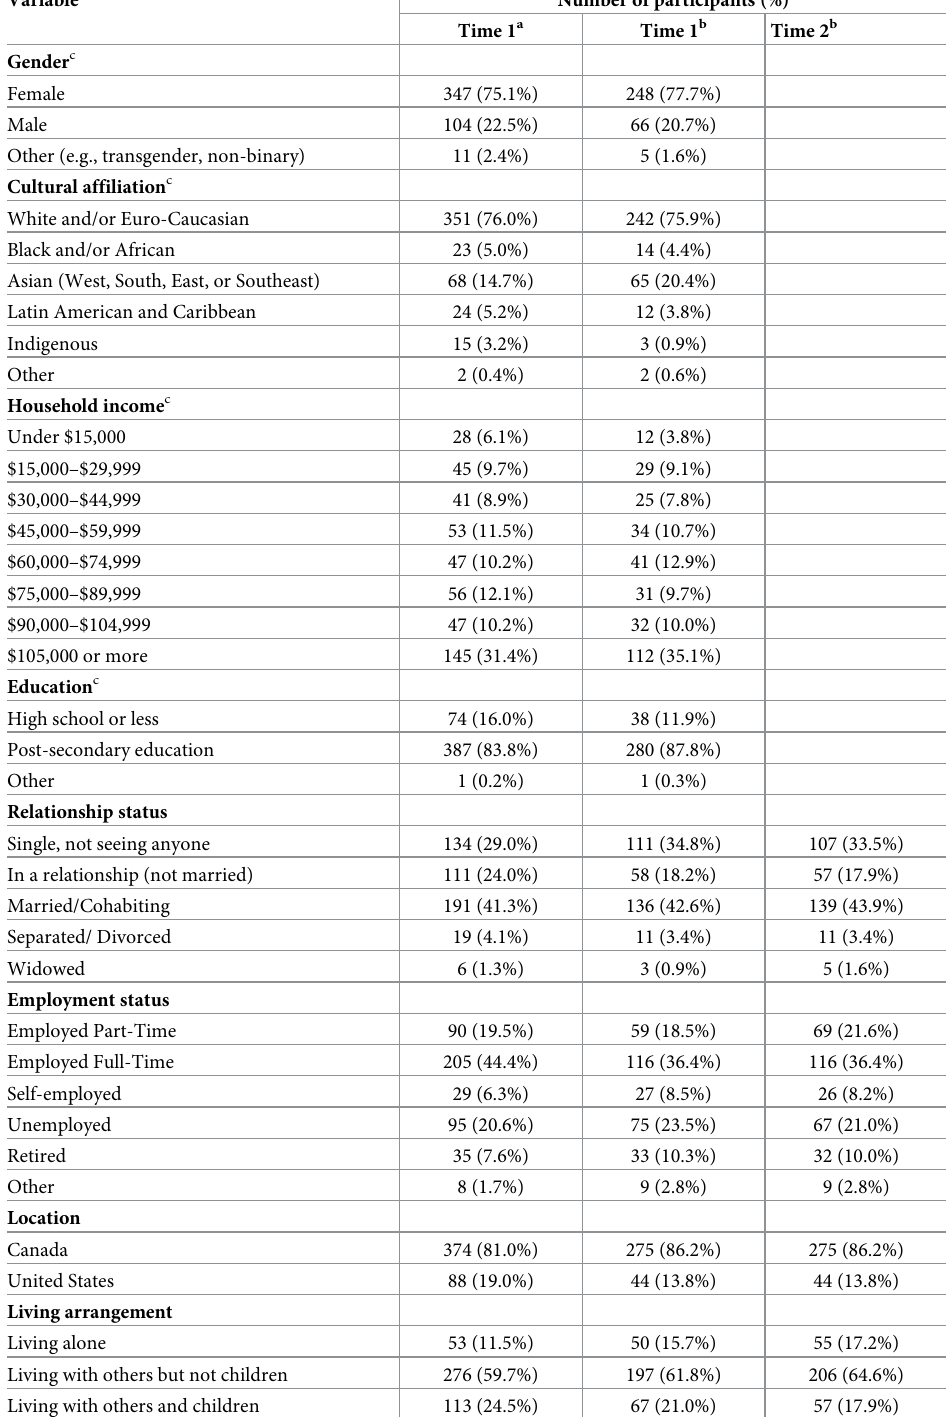
Table 1. Description of participant